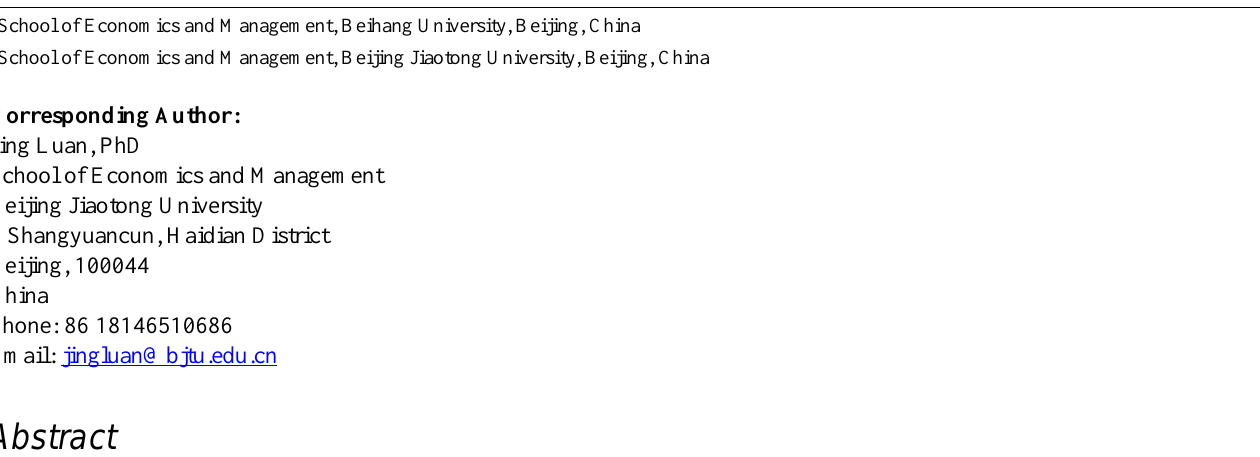
mHealth; physician information; choice;